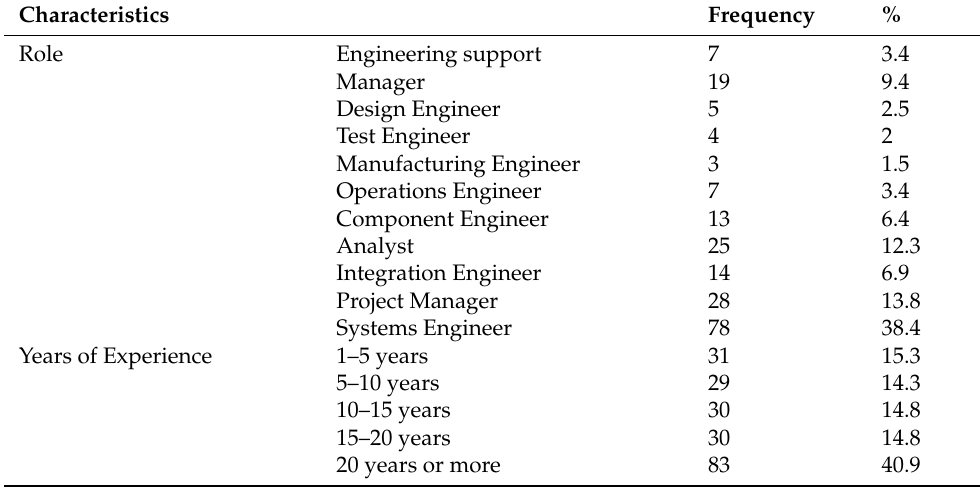
Table 4. Data Set ( n =